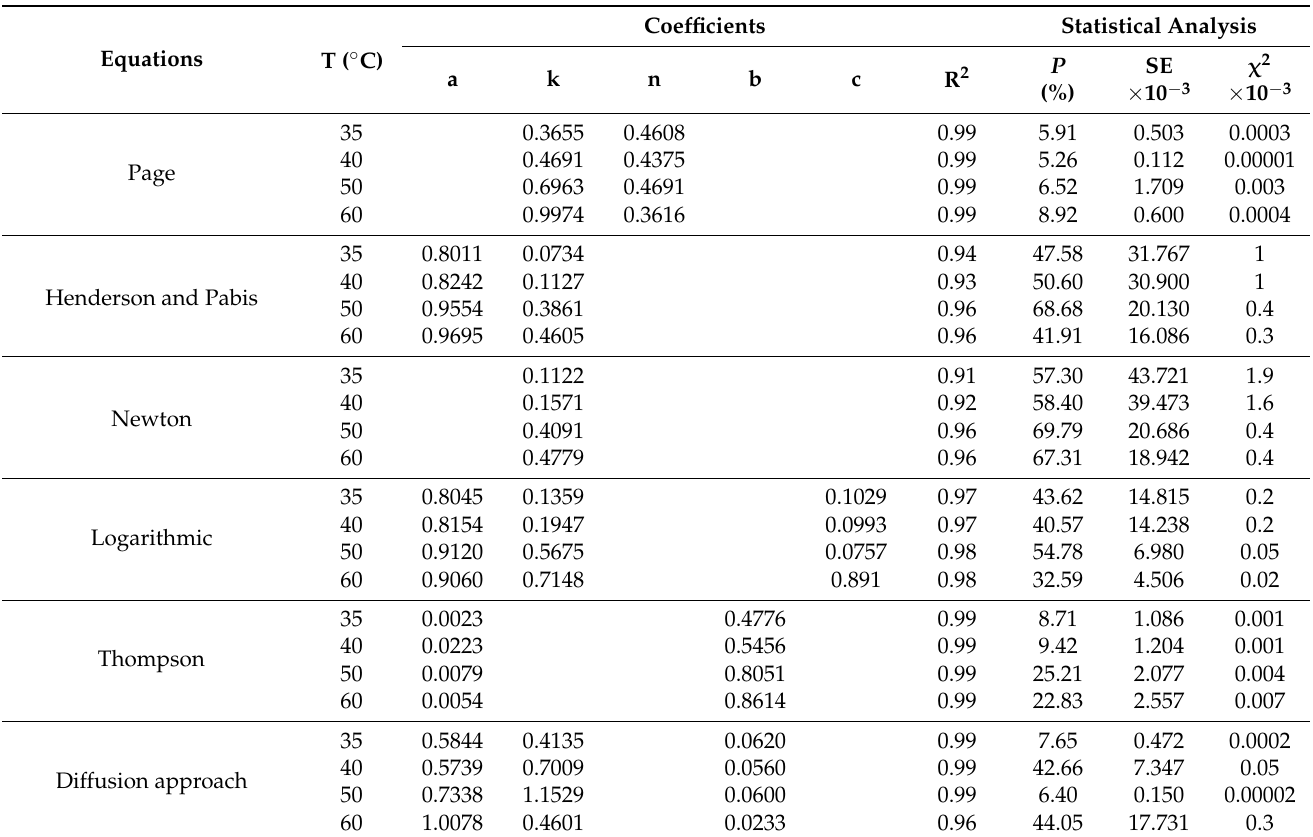
Table 3. Jambu drying adjustment parameters for different mathematical equations at temperatures of 35, 40, 50 and 60 ◦